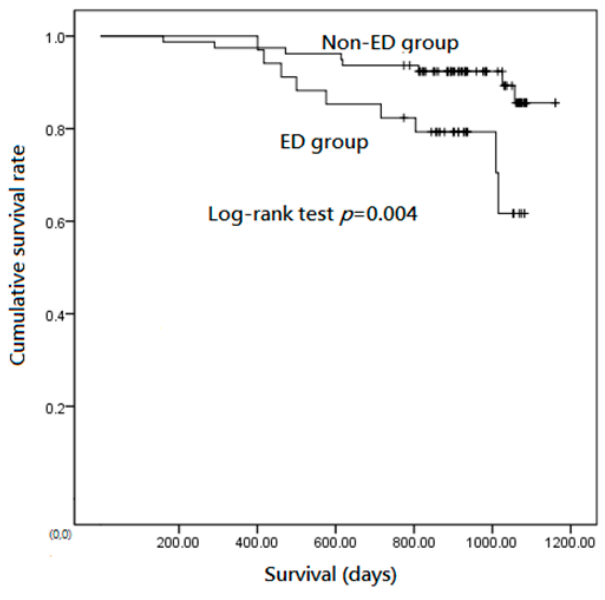
Figure 1. Kaplan–Meier analysis showed the cumulative survival rates of the exertional desaturation (ED) group were significantly lower than that of the non-ED group. Table 3. Univariate analysis and multivariate analysis of mortality in patients with stable COPD by cox regression